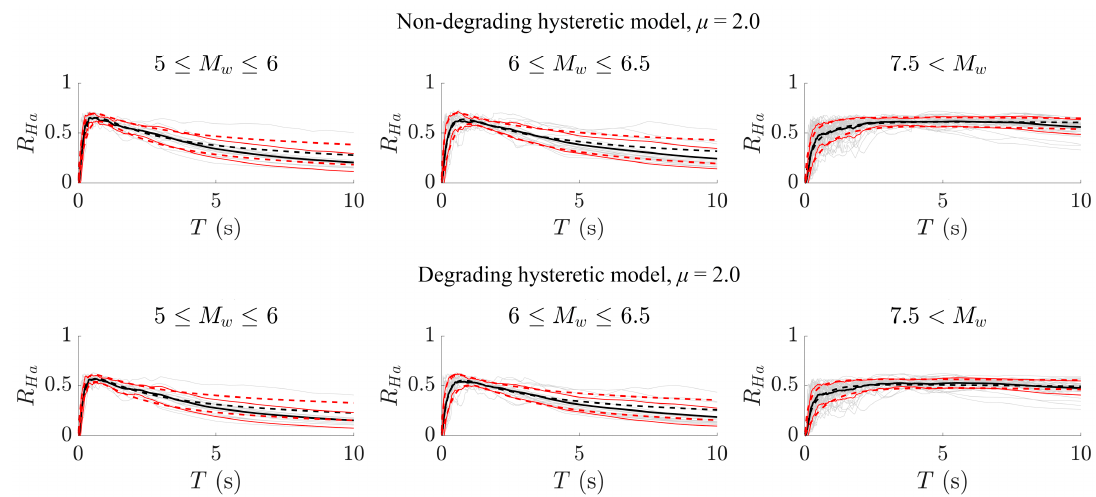
Figure 11. Comparison between calculated absolute input energy reduction factor R Ea spectra (mean and mean plus/minus one standard deviation) and proposed approximation (thin solid line: single spectrum; thick solid line: calculated spectrum; thick dashed line: proposed approximation).